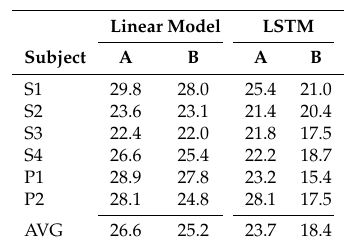
Table 7. Inter-subject RMS Error [mm] for the case where no target subject data is used (A) and the case where 60 s of target subject standing data is used to improve pre-trained models (B).